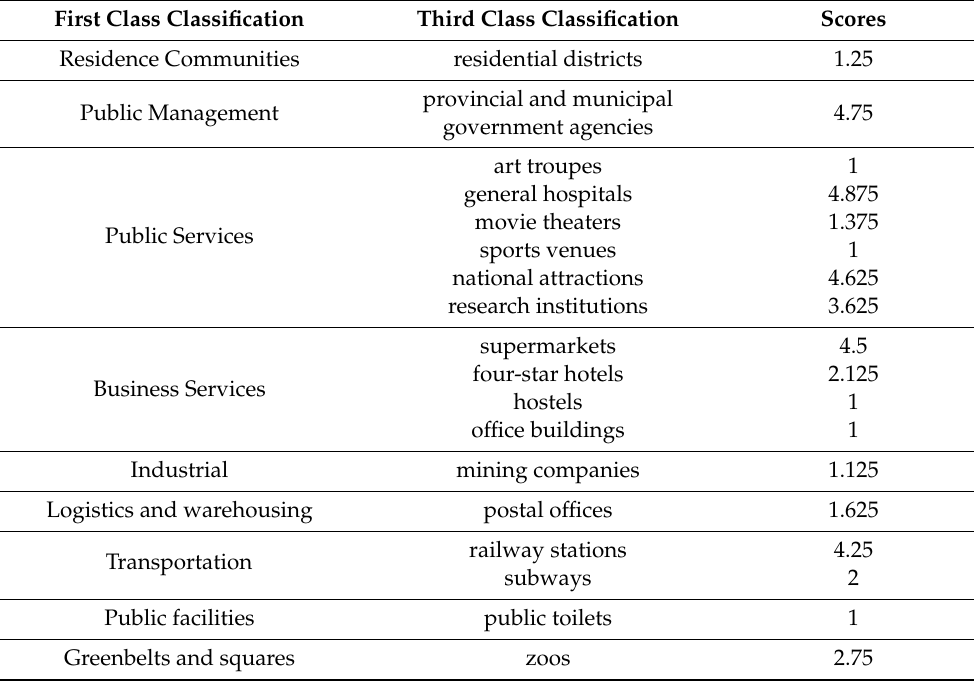
Table 4. Scores of partial POI